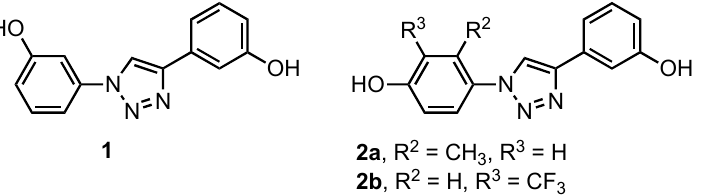
Figure 2. Structures of 1,4-di(hydroxyphenyl)-1,2,3-triazoles with reported estrogen receptor binding activity.